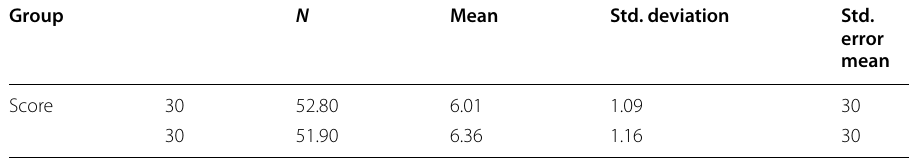
Table 21 Self‑efficacy pre‑test descriptive statistics Group N Mean Std.